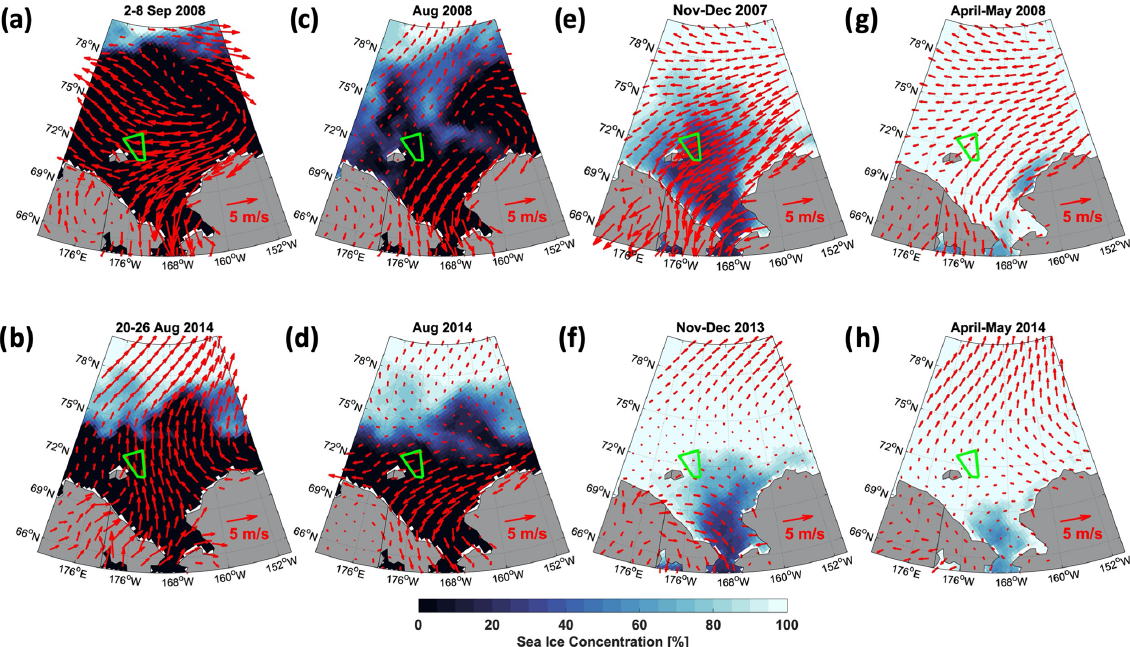
Figure 6. Wind velocities (red vectors) and sea ice concentration (shaded) for 2007/08 and 2013/14 for (a, b) the week before and including the CTD surveys, (c, d) an August mean for each year, (e, f) the sea ice growth season the preceding autumn (November–December mean), and (g, h) spring conditions for each year (April–May